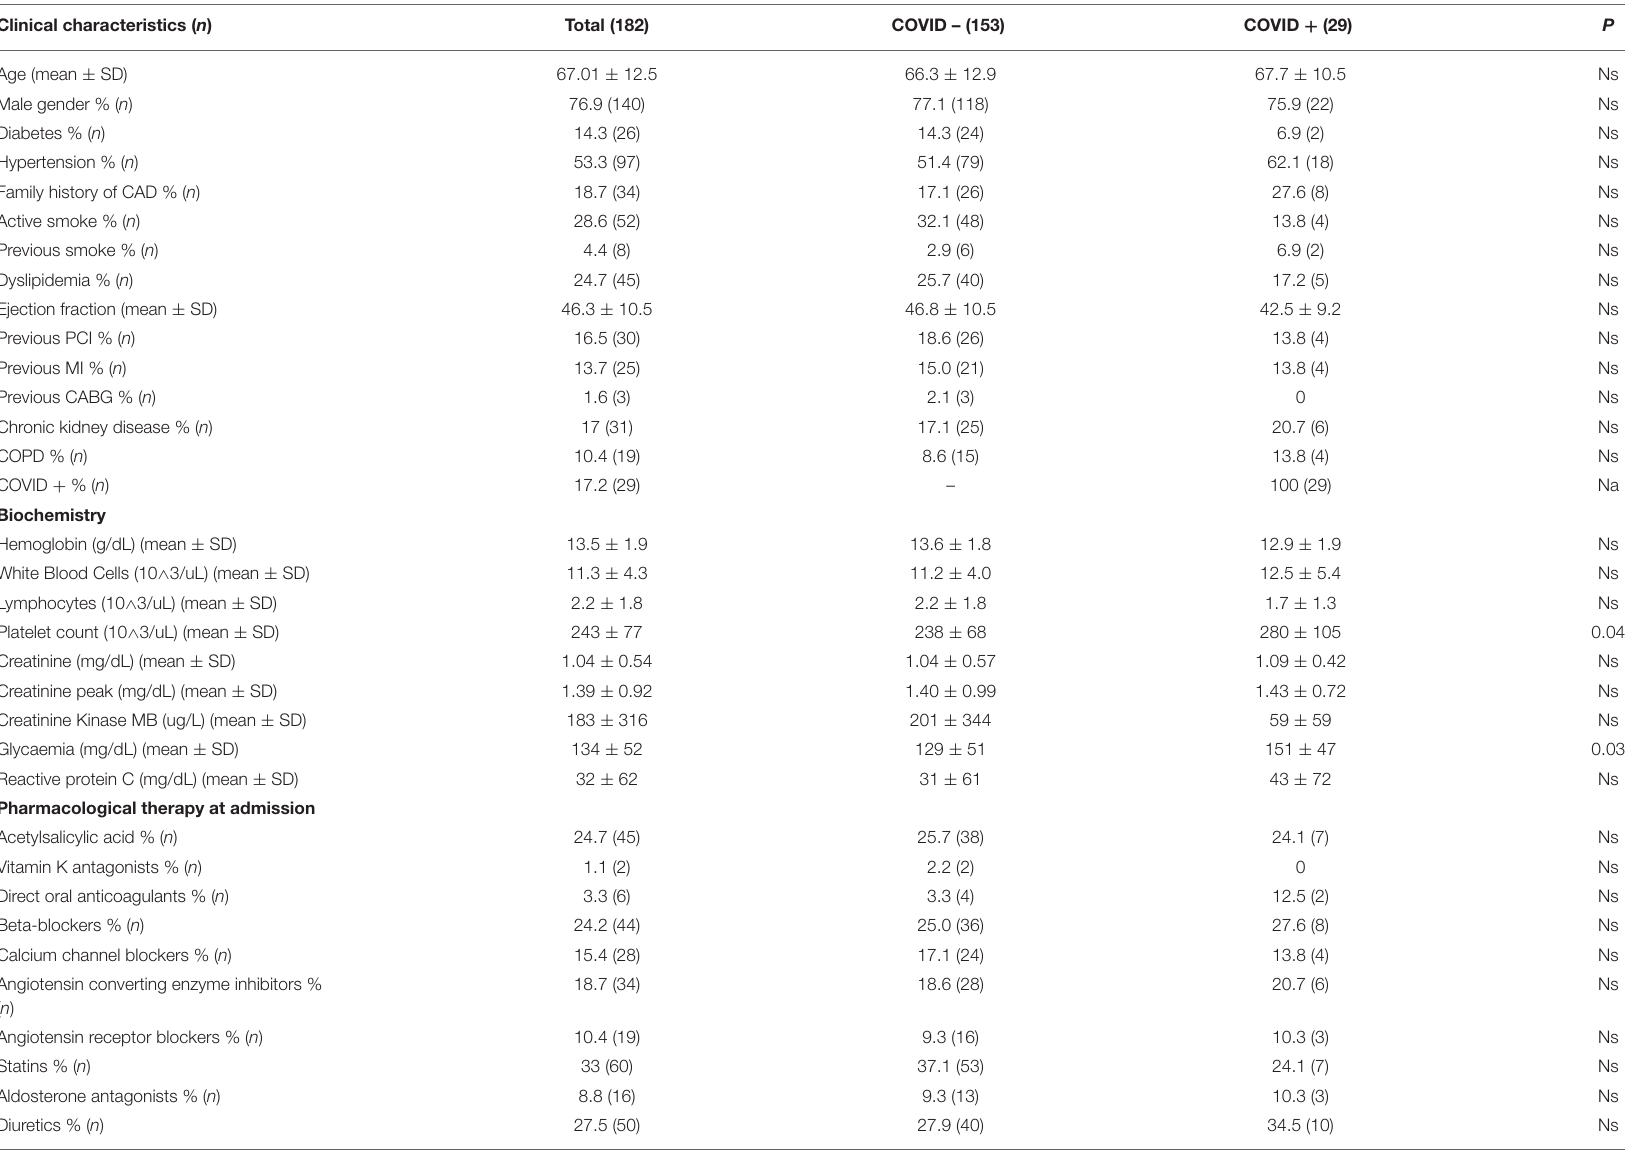
TABLE 1 | Baseline characteristics of the population. Clinical characteristics ( n